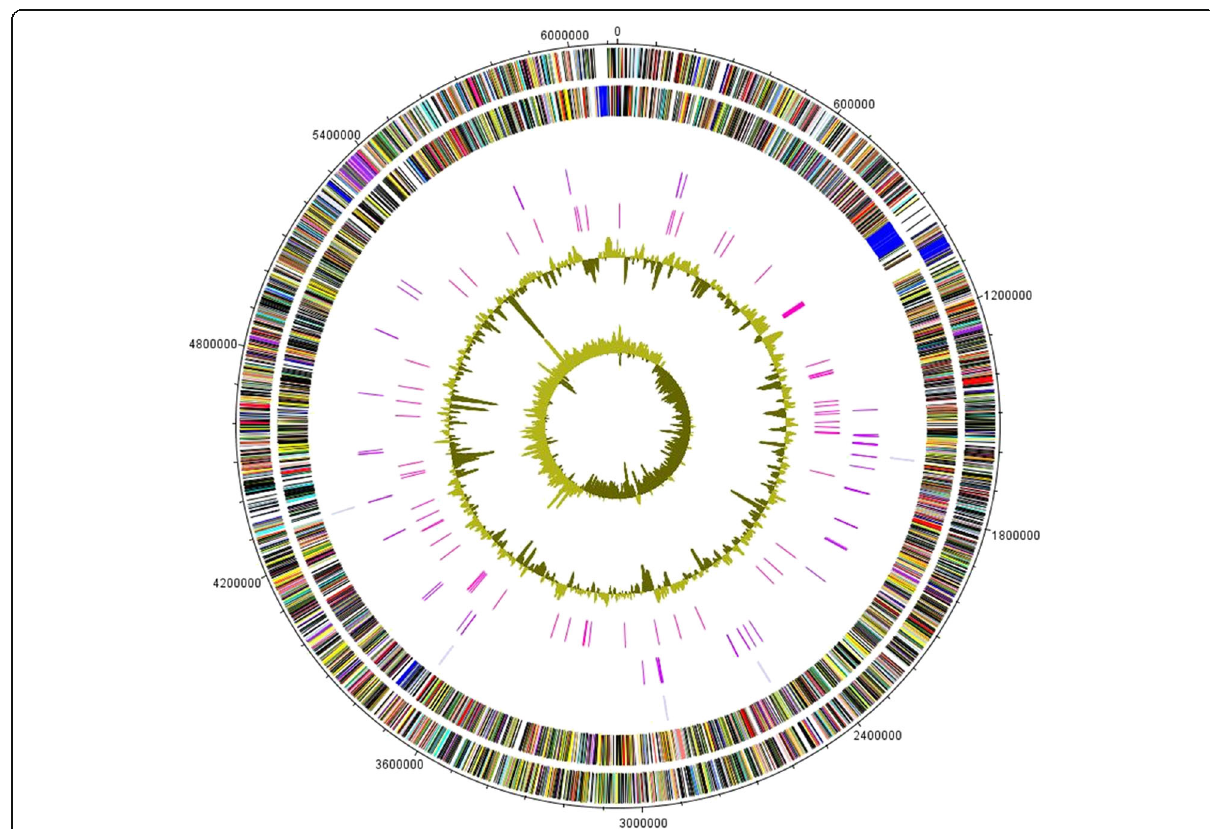
Fig. 3 Graphical map of the chromosome. The outer scale is marked every 10 kb. Circles range from 1 (outer circle) to 7 (inner circle). Circle 1 and 2, ORFs encoded by leading and lagging strand respectively, with color code for functions: salmon, translation, ribosomal structure and biogenesis; aquamarine, RNA processing and modification; light blue, transcription; cyan, DNA replication, recombination and repair; tan, chromatin structure and dynamics; turquoise, cell division; dark orange, defense mechanisms; deep pink, post-translational modification, protein turnover and chaperones; dark olive green, cell envelope biogenesis; purple, cell motility and secretion; lavender, intracellular trafficking, secretion, and vesicular transport; forest green, inorganic ion transport and metabolism; pink, signal transduction; red, energy production; sienna, carbohydrate transport and metabolism; yellow, amino acid transport; orange, nucleotide transport and metabolism; gold, co-enzyme transport and metabolism; cornflower blue, lipid metabolism; blue, secondary metabolites, transport and catabolism; gray, general function prediction only; yellow green, unknown function; black, function unclassified or unknown. Circle 3 and 4, distributions of tRNA genes and rrn operons respectively. Circle 5, distribution of pseudogenes. Circle 6 and 7, G + C content and GC skew (G-C/G + C)